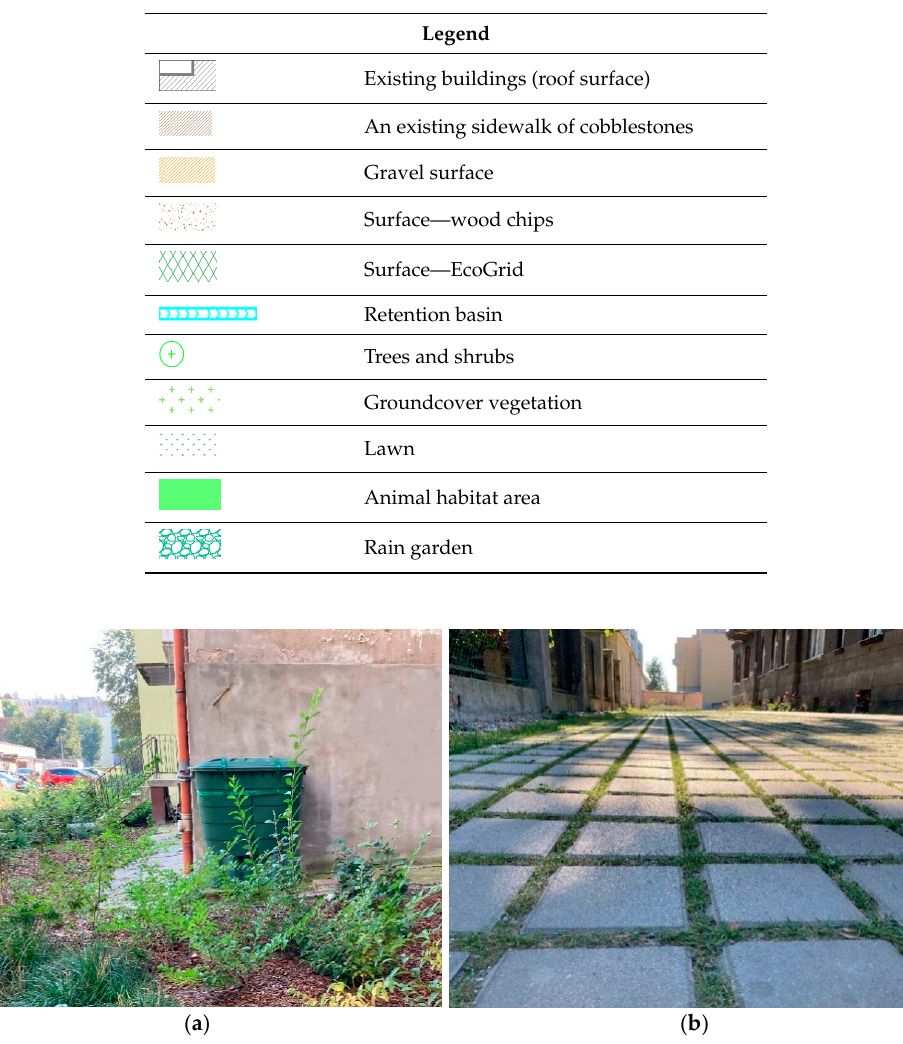
Figure 2. Selected nature-based solutions (NBSs). ( a ) Rainwater tank—a tank made of polyethylene (PE), characterized by a particular resistance to the effects of UV radiation and resistance to changing weather conditions. Water intake occurs through the valve. The service life of the tank is approximately 20 years. ( b ) Surface—EcoGrid—a surface made of concrete cubes in an orthogonal system; the gaps are filled with growing medium and grass. 2.2. Data Analysis The potential variability of the retained water amount as a result of the NBSs implementation was estimated based on the change in the amount of rainwater drained into the rainwater sewage system before and after the implementation of the NBSs based on the calculation of the share of